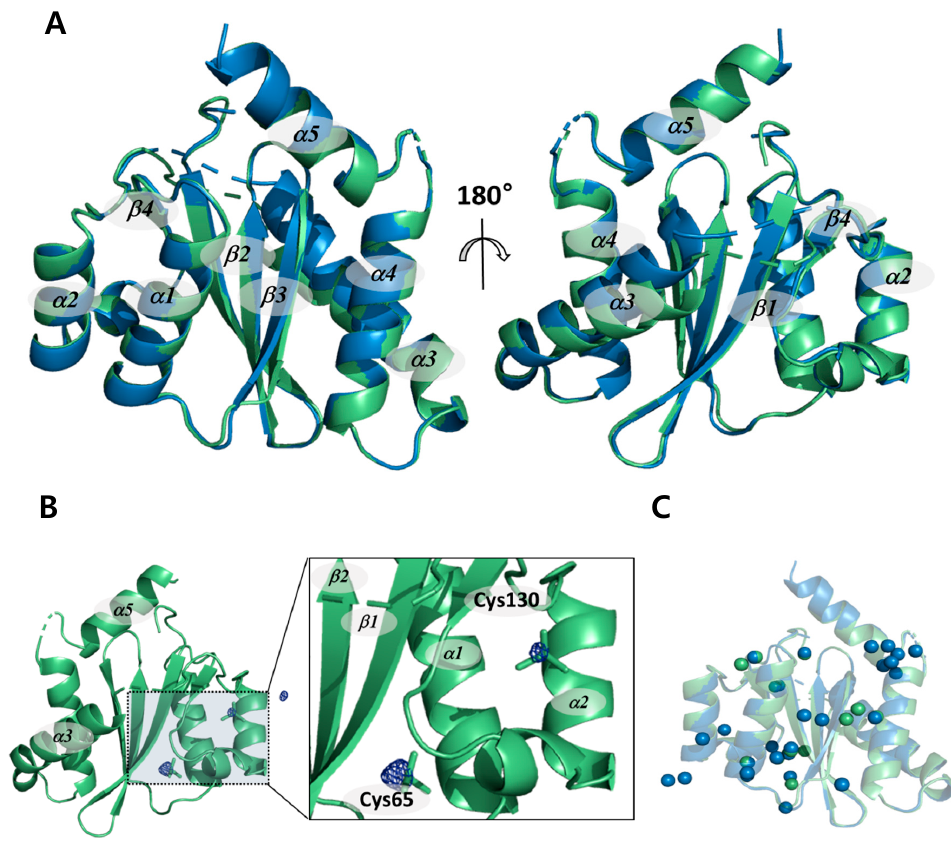
Figure 1. Comparison of the crystal structures of HIV-1 integrase catalytic core domain at both cryogenic and non-cryogenic temperature. ( A ) Superimposed non-cryogenic (green) and cryogenic (blue) structures. ( B ) Non-cryogenic (green) structure plotted together with the |F obs | non-cryo – |F obs | cryo difference Fourier electron density map contoured level at 4.5 σ . Positive maps were marked by blue mesh. ( C ) Water molecule positions of non-cryogenic (green) and cryogenic (blue) structures.